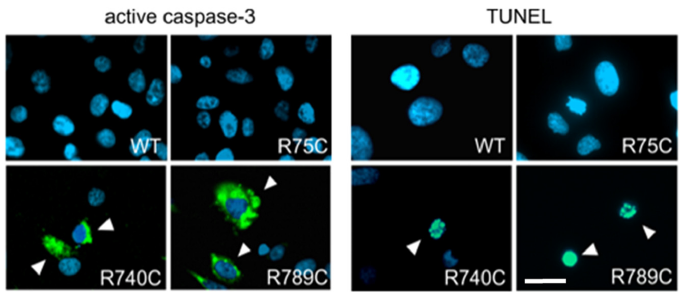
Figure 6. Detection of apoptosis in HT1080 cells transfected with collagen II constructs. HT1080 cells transfected with collagen II constructs were analyzed three days post-transfection for the presence of active caspase-3 (green) as a marker for apoptosis. Active caspase-3 was only found in cells expressing R740C and R789C collagens (left panel, indicated by arrow heads). Four days after transfection, HT1080 cells transfected with R740C and R789C constructs were positive for TUNEL staining (green, right panel, indicated by arrow heads). Nick labeling was neither seen in non-transfected cells, nor in cells transfected with other collagen constructs (Supplemental Figure S1). Scale bar, 25 µm.